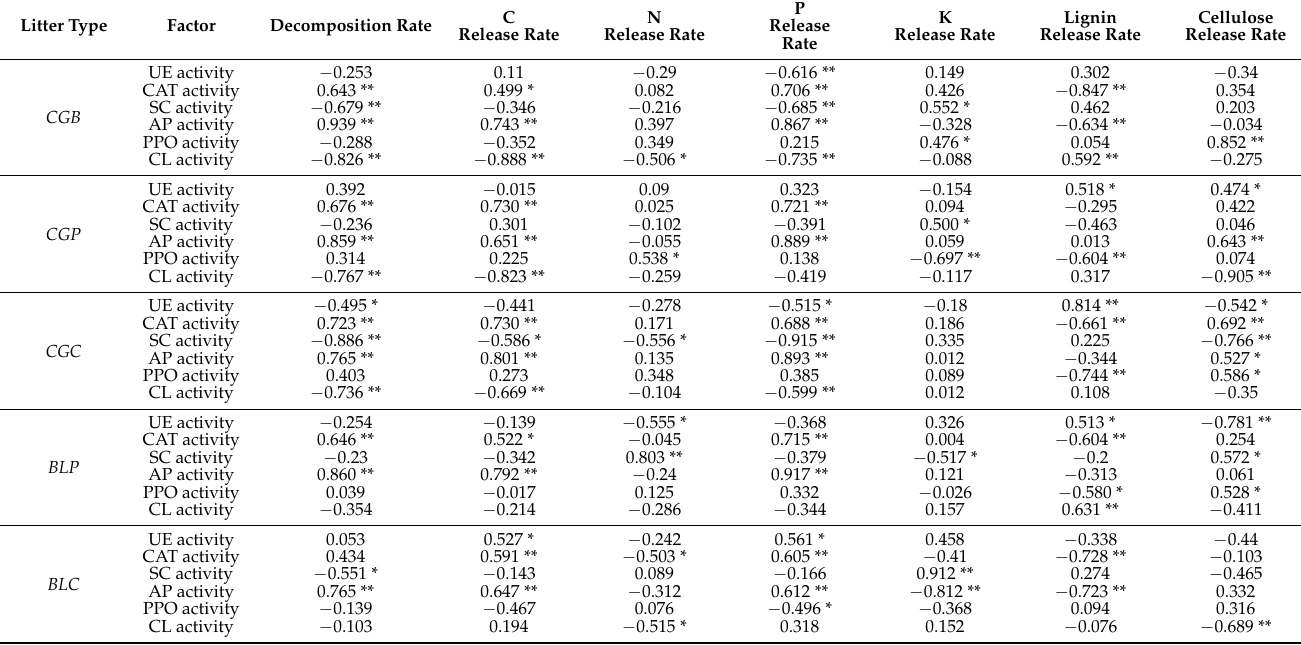
Table 3. Correlation of decomposition rate, nutrient release rate and enzyme activity of different